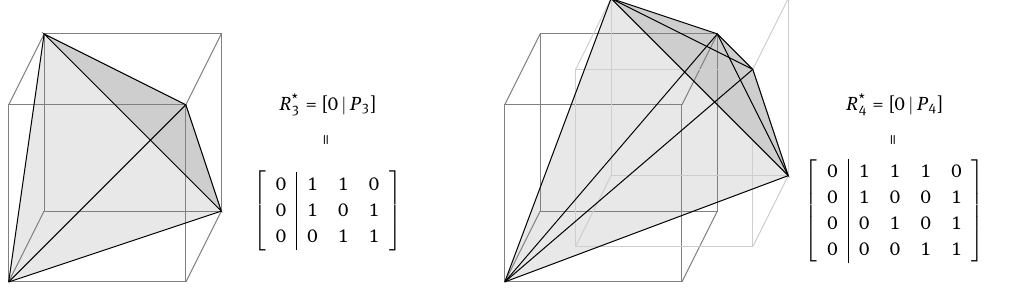
Figure 12: An acute antipodal n -simplex for n = 3 (left) and n = 4 (right) together with their minimal matrix representations R * 3 and their nonsingular parts P 3 and P 4 that satisfy the conditions in Definition and R * 4